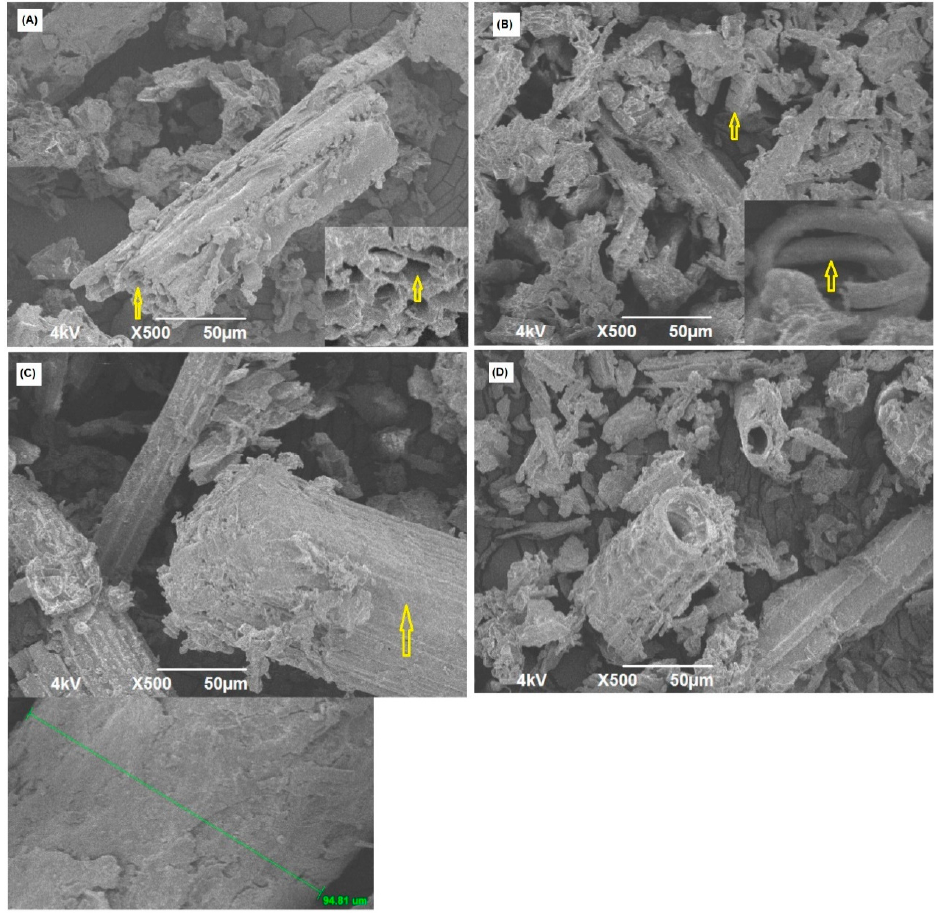
Figure 2. Scanning electron micrographs of DPWP: ( A ) leaflet (L), ( B ) rachis (R), ( C ) fibers (F), and ( D ) composite (M) at 500× magnification.